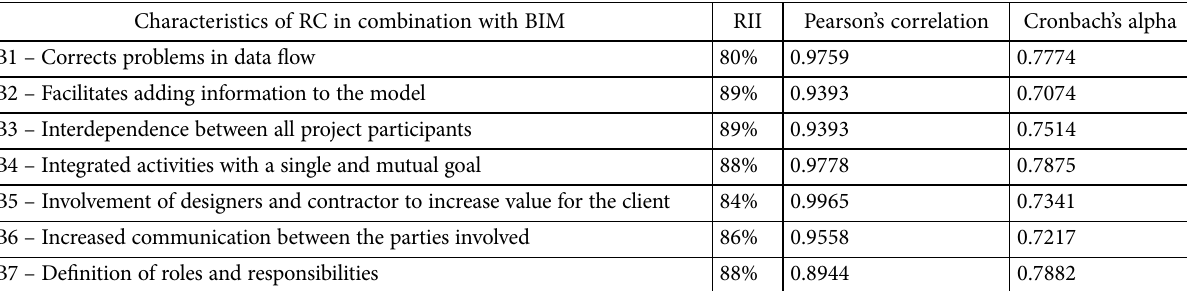
Table 5. Main characteristics of RC in combination with the BIM methodology that contribute to reducing